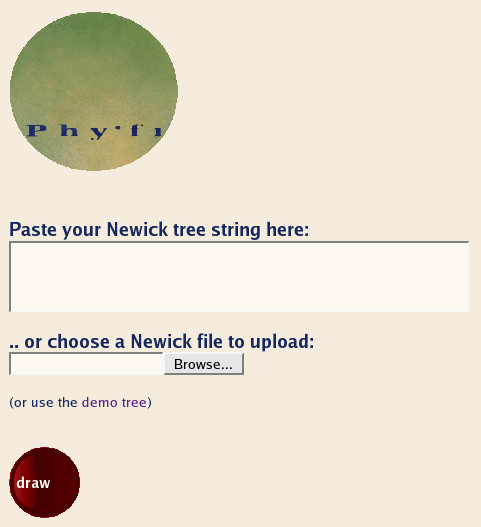
The very straight-forward front page of PHY·FI.